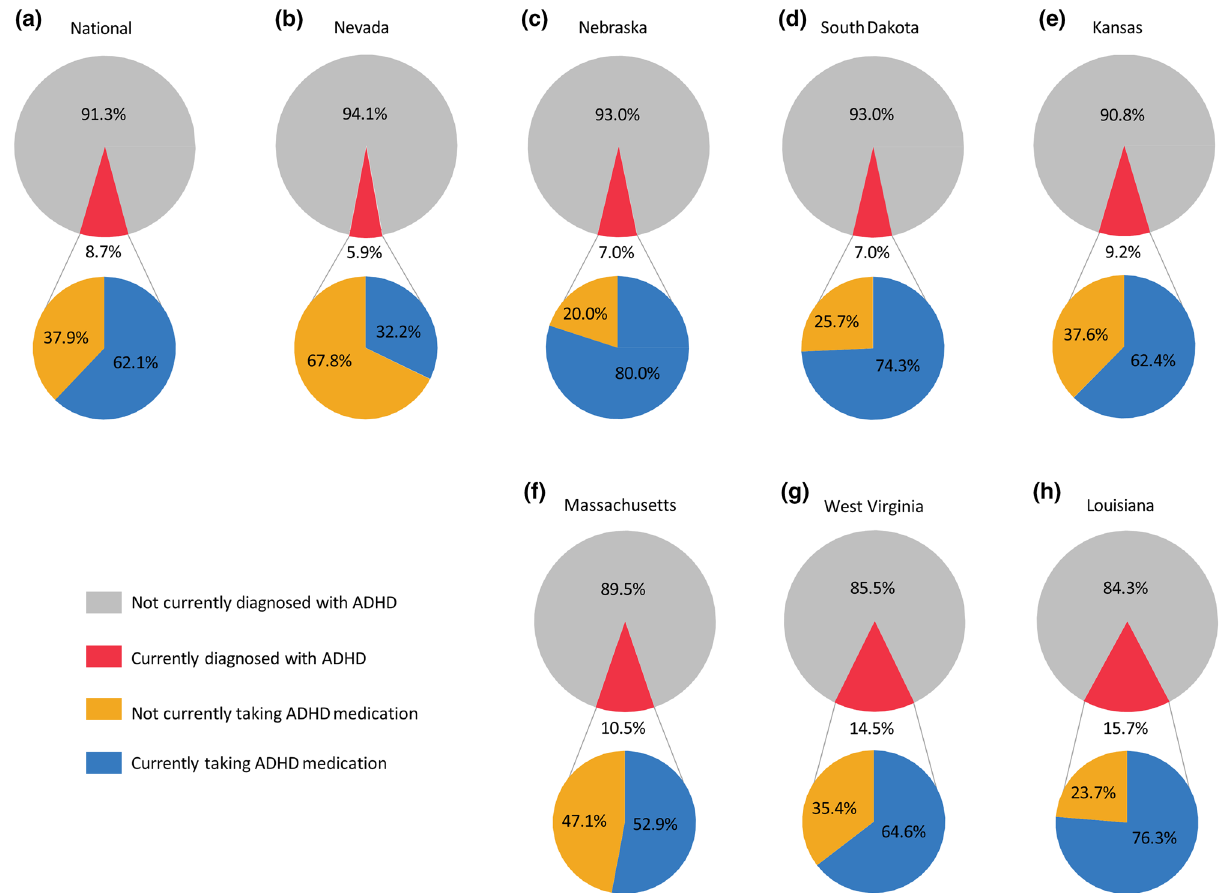
Figure 2. Compared to estimates of ( a ) the national population (n = 51,916), ( b – h ) the represented states vary from 5.9 to 15.7% of children age 3–17 years diagnosed with ADHD and 32.2% to 76.3% of children taking ADHD medication among those diagnosed. From lowest to highest rate of diagnosis, the states represented are Nevada (n = 994), Nebraska (n = 953), South Dakota (n = 960), Kansas (n = 1,045), Massachusetts (n = 1,029), West Virginia (n = 1,082), and Louisiana (n = 1,080). Gray indicates children that are not currently diagnosed with ADHD and red indicates children that are currently diagnosed with ADHD. Blue indicates children that are currently diagnosed with ADHD and are taking ADHD medication, and orange indicates children that are currently diagnosed with ADHD but are not taking ADHD medication. ( b ) Nevada represents particularly low rates of diagnosis and medication, while ( h ) Louisiana represents particularly high rates of diagnosis and medication. Data were collected from the NSCH 2018–2019 combined ADHD diagnosis and treatment variation among representative states. Of all states, Louisiana (LA; 15.7%) has the highest percentage of children diagnosed with ADHD and California (CA; 5.6%) has the lowest, followed by Nevada (NV; 5.9%; Figs. 1a, 2). The percentage of children taking ADHD medication among those diagnosed (Fig. 1b) is highest in NE (80.0%), third highest in LA (76.3%), and lowest in NV (32.2%). Kan- sas (KS) diagnosis (9.2%) and medication (62.4%) rates are closest to the median rates of all states. NE and South Dakota (SD) have low diagnosis rates (7.0% for both), but high medication rates (80.0% and 74.3%, respectively) relative to the median rates. Massachusetts (MA) and West Virginia (WV) have high diagnosis rates (10.5% and 14.5%, respectively), but MA has a low medication rate (52.9%), while WV has a near-median medication rate (64.6%; Fig. 2). Multiple correspondence analysis of ADHD diagnosis and SES factors. Individual NSCH responses were analyzed nationally (n = 59,445), within LA (n = 1255), and within NV (n = 1154). Of all ana- lyzed individual response data, 6.7% were missing and imputed for Multiple Correspondence Analysis (MCA; Fig. 3a–c). In MCA, inter-variable proximity indicates the strength of possible associations. The national dataset analysis resulted in 43 dimensions, with inertias ranging from 0.2% to 6.8% and a total inertia of 13.2% for the first two dimensions. LA analysis resulted in 42 dimensions, with inertias ranging from 0.2% to 7.4% and a total inertia of 13.6% for the first two dimensions. NV analysis resulted in 41 dimensions, with inertias ranging from 0.2% to 8.1%, and a total inertia of 13.9% for the first two dimensions.